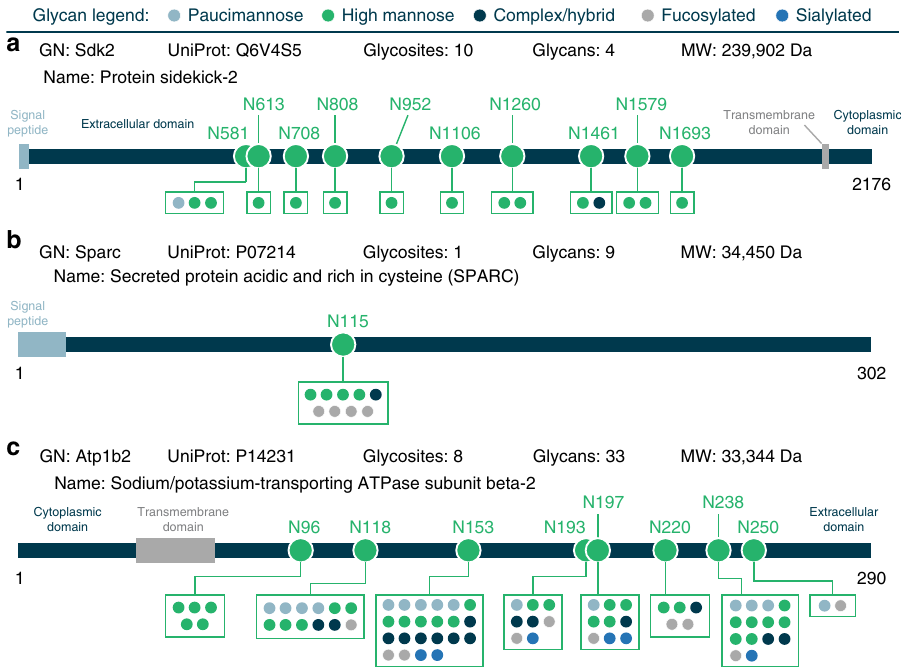
Fig. 5 Glycan microheterogeneity can manifest in several different forms. Glycosites can have small or large degrees of glycan heterogeneity, and this level of glycan diversity can even differ for glycosites on the same protein. Here three examples of different modes of heterogeneity are provided: a several glycosites on one protein with limited glycan heterogeneity (Protein sidekick-2), b a protein with one glycosite that has some degree of heterogeneity (SPARC), and c several glycosites on one protein that show either low or high glycan heterogeneity (Na/K-transporting ATPase subunit